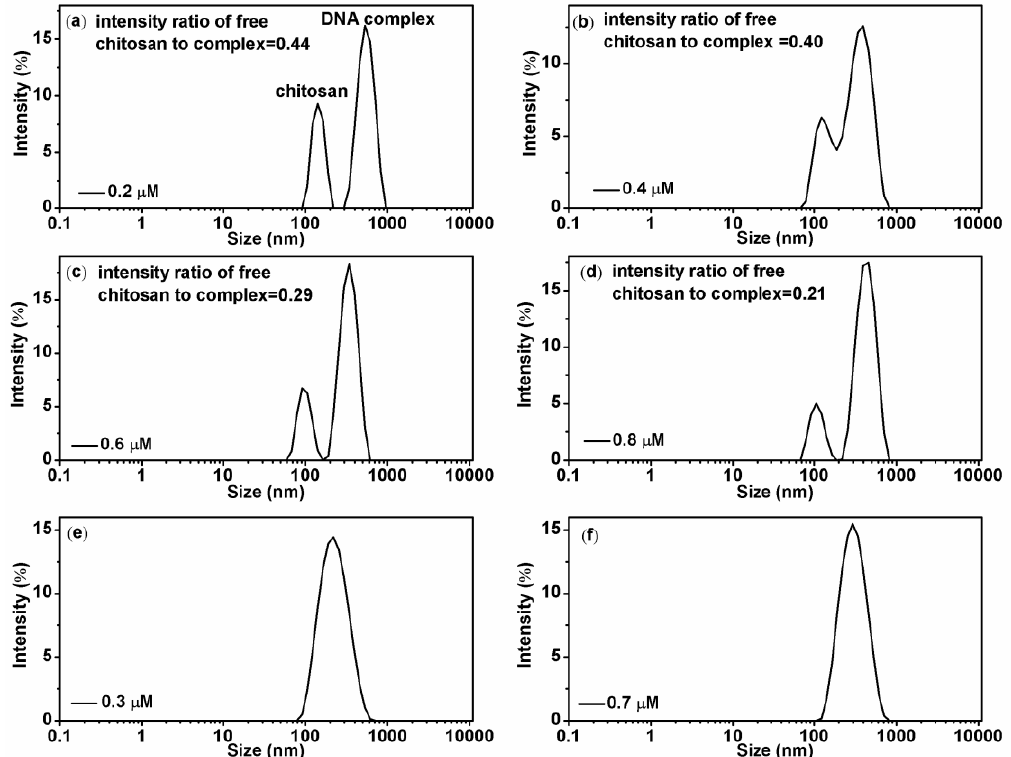
Figure 4. ( a – d ): Chitosan-DNA complexes size distribution with different chitosan concentrations (0.2 µ M, 0.4 µ M, 0.6 µ M and 0.8 µ M; corresponding, k are 1.9, 3.8, 5.7 and 7.6) at pH = 4.6, intensity ratio of free chitosan to complex are 0.44, 0.40, 0.29, and 0.21, respectively. ( e , f ): size distributions at pH = 6, the concentration of chitosan is 0.3 µ M and 0.7 µ M ( k are 2.85 and 6.65), respectively.